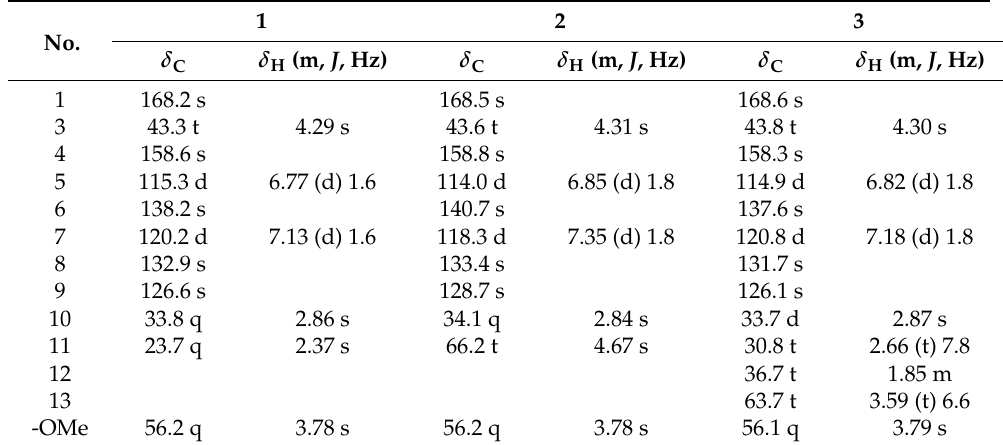
Table 1. 1 H and 13 C NMR data for compounds 1 – 3 (in CDCl3, 500 and 125 MHz).